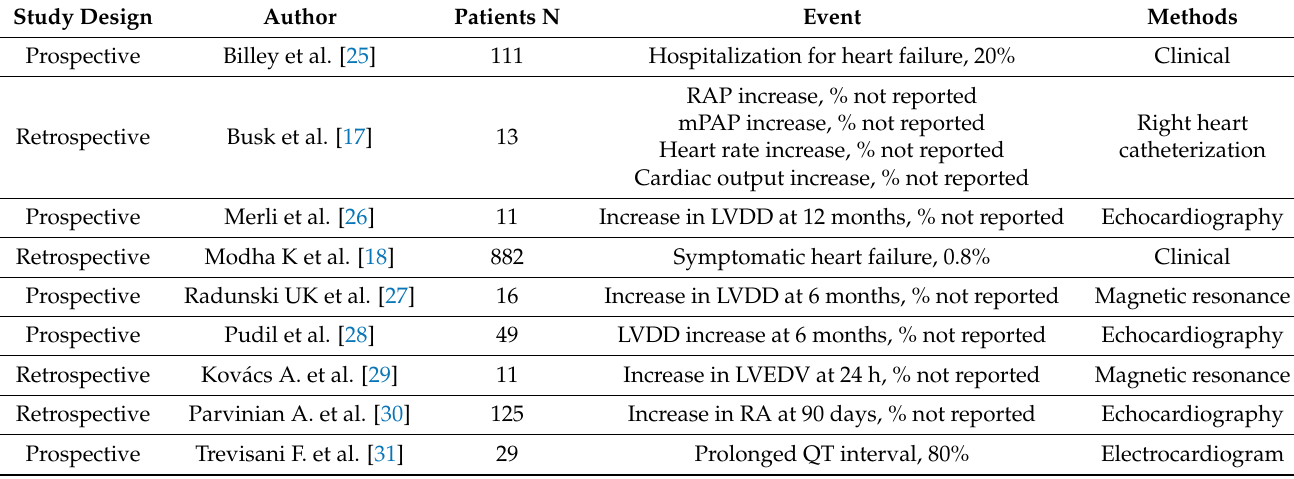
Table 1. Cardiac complications related to transjugular intrahepatic portosystemic